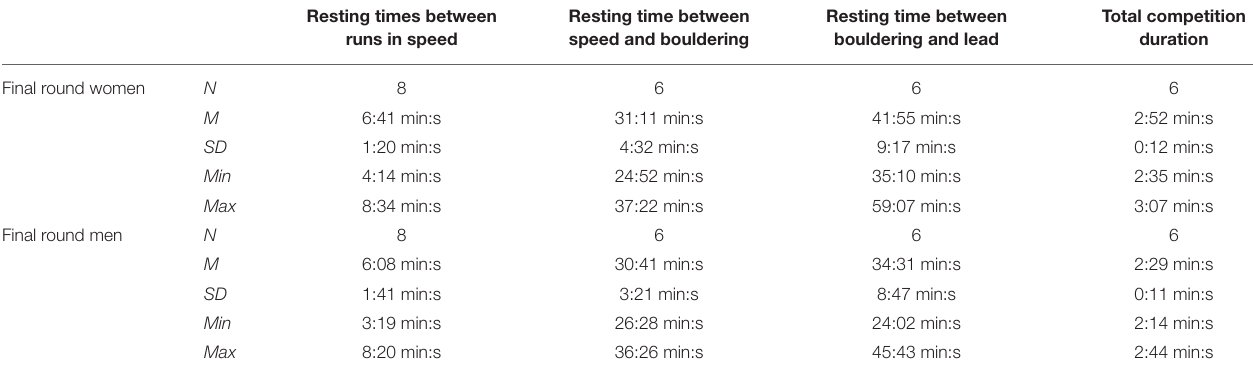
TABLE 5 | Statistics of international Olympic combined climbing competitions.